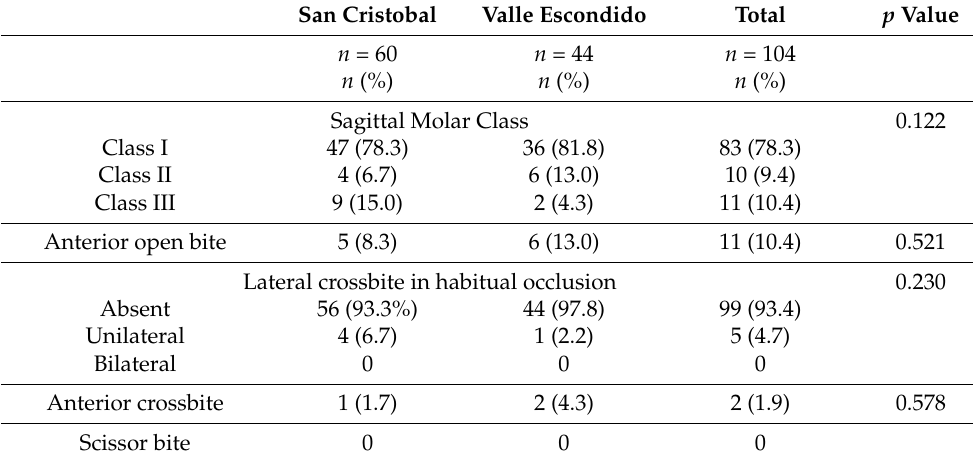
Table 4. Orthodontic characteristics in study population.